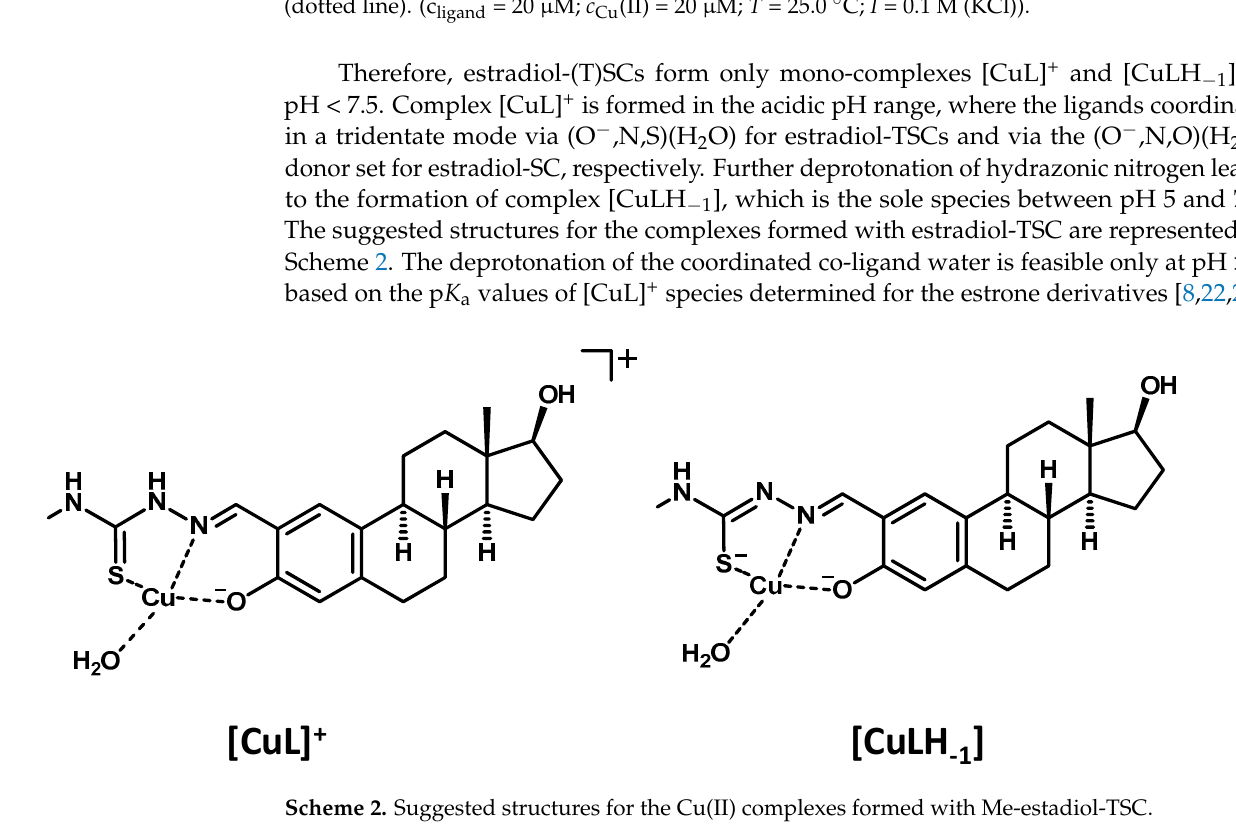
0.05 4 1 Data are taken from Ref. [23]; 2 data are taken from Ref. [8]; 3 data are taken from Ref. [22]; 4 deter ‐ mined in this work; 5 estimated pCu values at 6.0; 6 Estimated pCu values at 7.4. 2.3. Synthesis, Characterization of Cu(II) Complexes of Estradiol–(T)SCs and Solid State Structural Studies of [Cu(HL)Cl 2 ] × H 2 O × 2CH 3 OH As the solution equilibrium studies indicated the formation of the Cu(II) complexes with high stability in solution, we attempted to isolate them. Therefore, the Cu(II) com ‐ plexes were prepared by the reaction of CuCl 2 ∙ 2H 2 O with estradiol ‐ (T)SC in a boiling